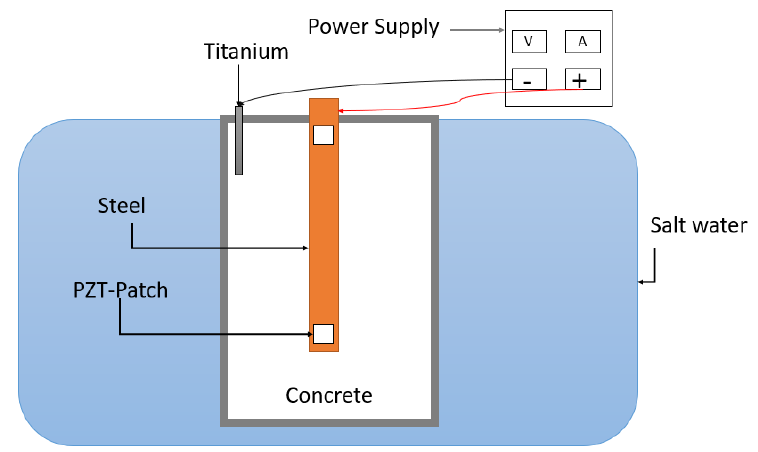
Figure 17. Impressed current technique for acceleration of corrosion damage in RC structure.